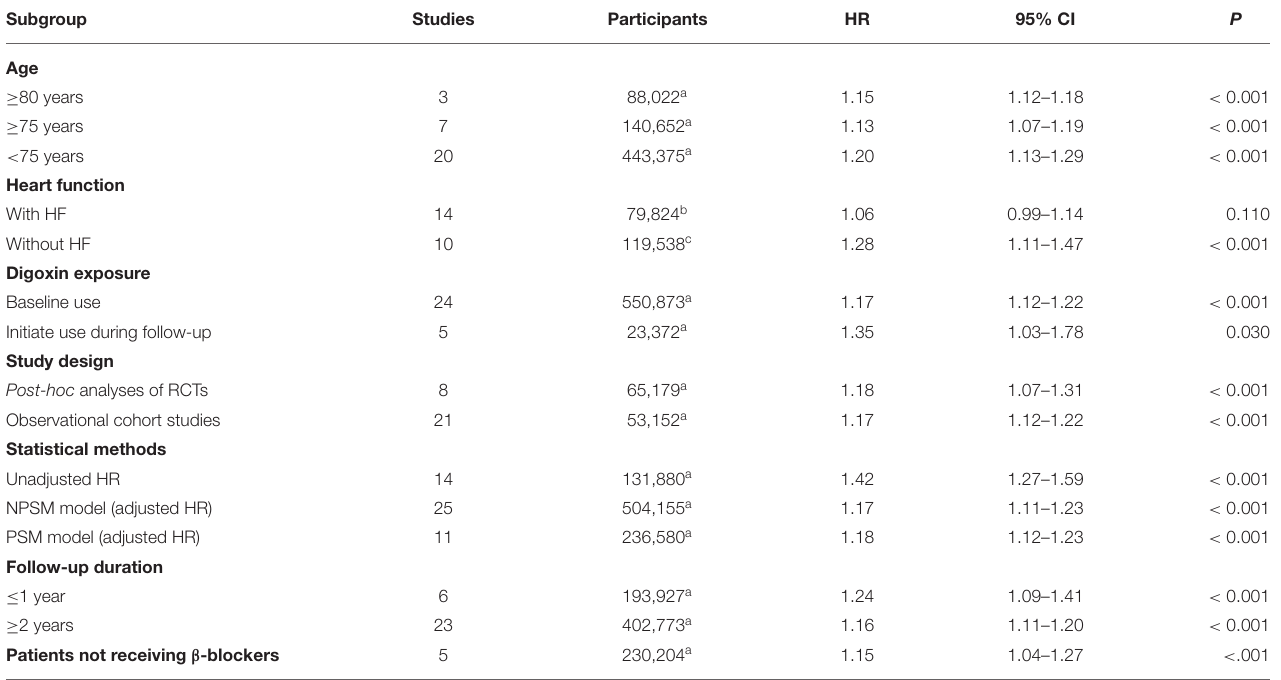
TABLE 2 | Subgroup analyses of the association between digoxin treatment and all-cause mortality. Subgroup